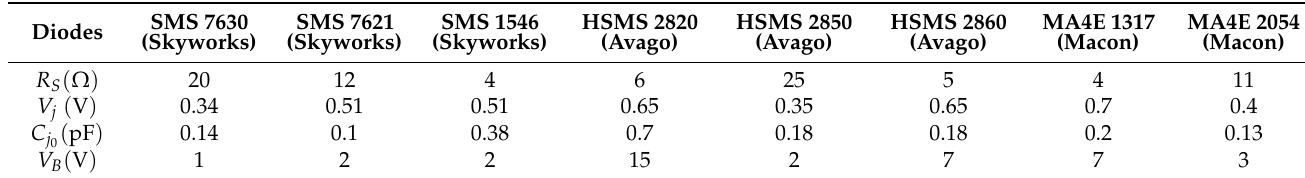
Table 3. Commonly used Schottky diodes in RF-EH system